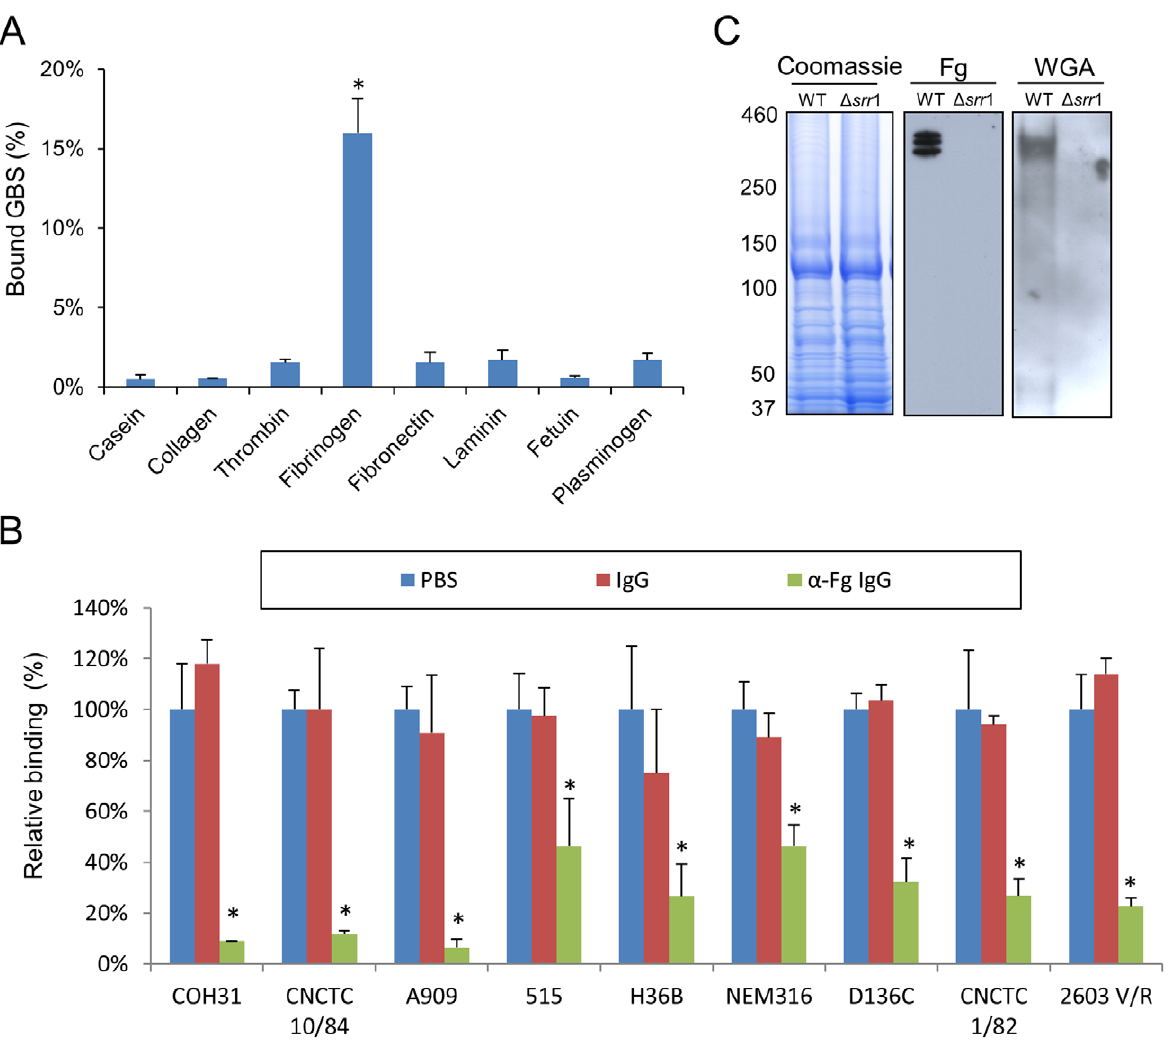
Figure 2. Binding of GBS to fibrinogen. (A) GBS strain COH31 strain was incubated with wells pretreated with collagen, thrombin, fibrinogen, fibronectin, laminin, fetuin, or plasminogen (0.1 m M per well). Values represent mean 6 S.D. of the percent of inoculum bound. (B) Immobilized fibrinogen was preincubated with rabbit anti-fibrinogen IgG (100 m g/ml) or rabbit IgG (100 m g/ml) prior to testing for binding by GBS. Unbound IgG was removed by washing and GBS binding was assessed. Values represent percent of GBS binding as compared with untreated fibrinogen. (C) Far Western blotting of cell wall proteins from strain COH1 (WT) and PS954 ( D srr1 ). Left panel shows SDS-PAGE of cell wall preparations. Proteins were transferred to nitrocellulose and probed with purified fibrinogen (fibrinogen; 10 m g/ml, middle panel) or biotinylated WGA lectin (0.2 m g/ml, right panel). Bound fibrinogen and lectin were detected with anti-fibrinogen IgG or HRP conjugated streptavidin, respectively. *=P , 0.01.